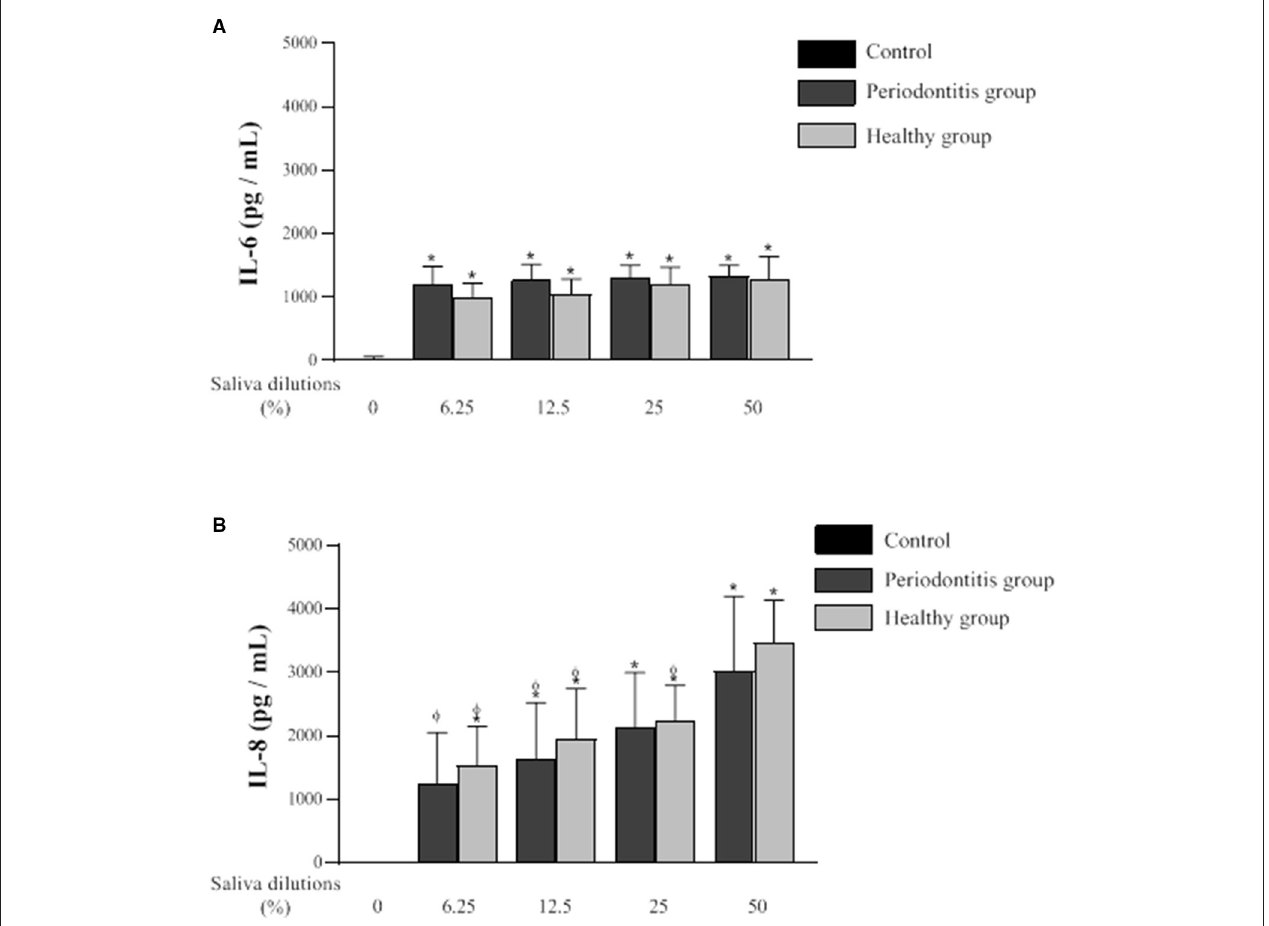
FIGURE 5 | Effect of various dilutions of filter-sterilized saliva from the periodontitis and healthy subjects on the secretion of IL-6 (A) and IL-8 (B) by oral epithelial cells (GMSM-K cell line) following a 24-h exposure. Data are expressed by subject group as the mean ± SD of cytokine concentrations determined in triplicate assays. The difference with the control group was considered to be significant at p < 0.05 (*). A difference with the respective 50% saliva dilutions was considered to be significant at p < 0.05 ( φ ). No significant difference was observed between the periodontitis and healthy groups at any saliva